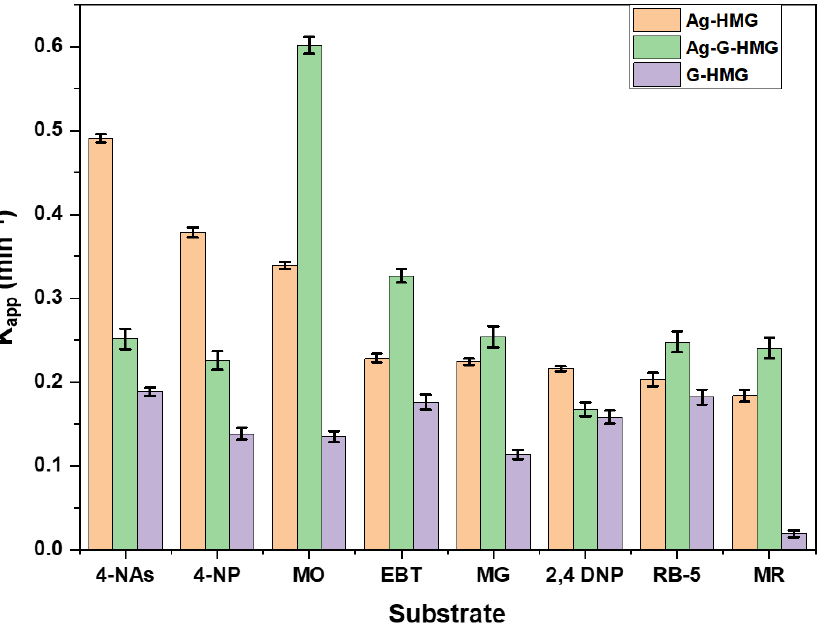
Figure 3. A plot of comparisons of the k app of different substrates reduced through the use of different hybrid microgels as